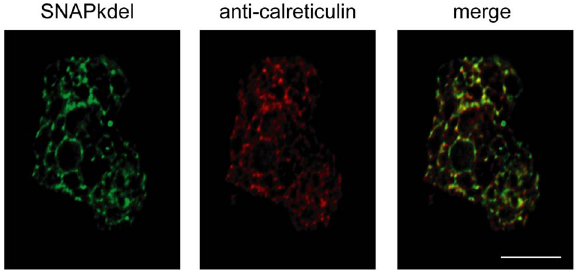
Figure 2. Colocalization of the SNAP-kdel protein with E. histolytica calreticulin. This ameba was fixed and labeled using a